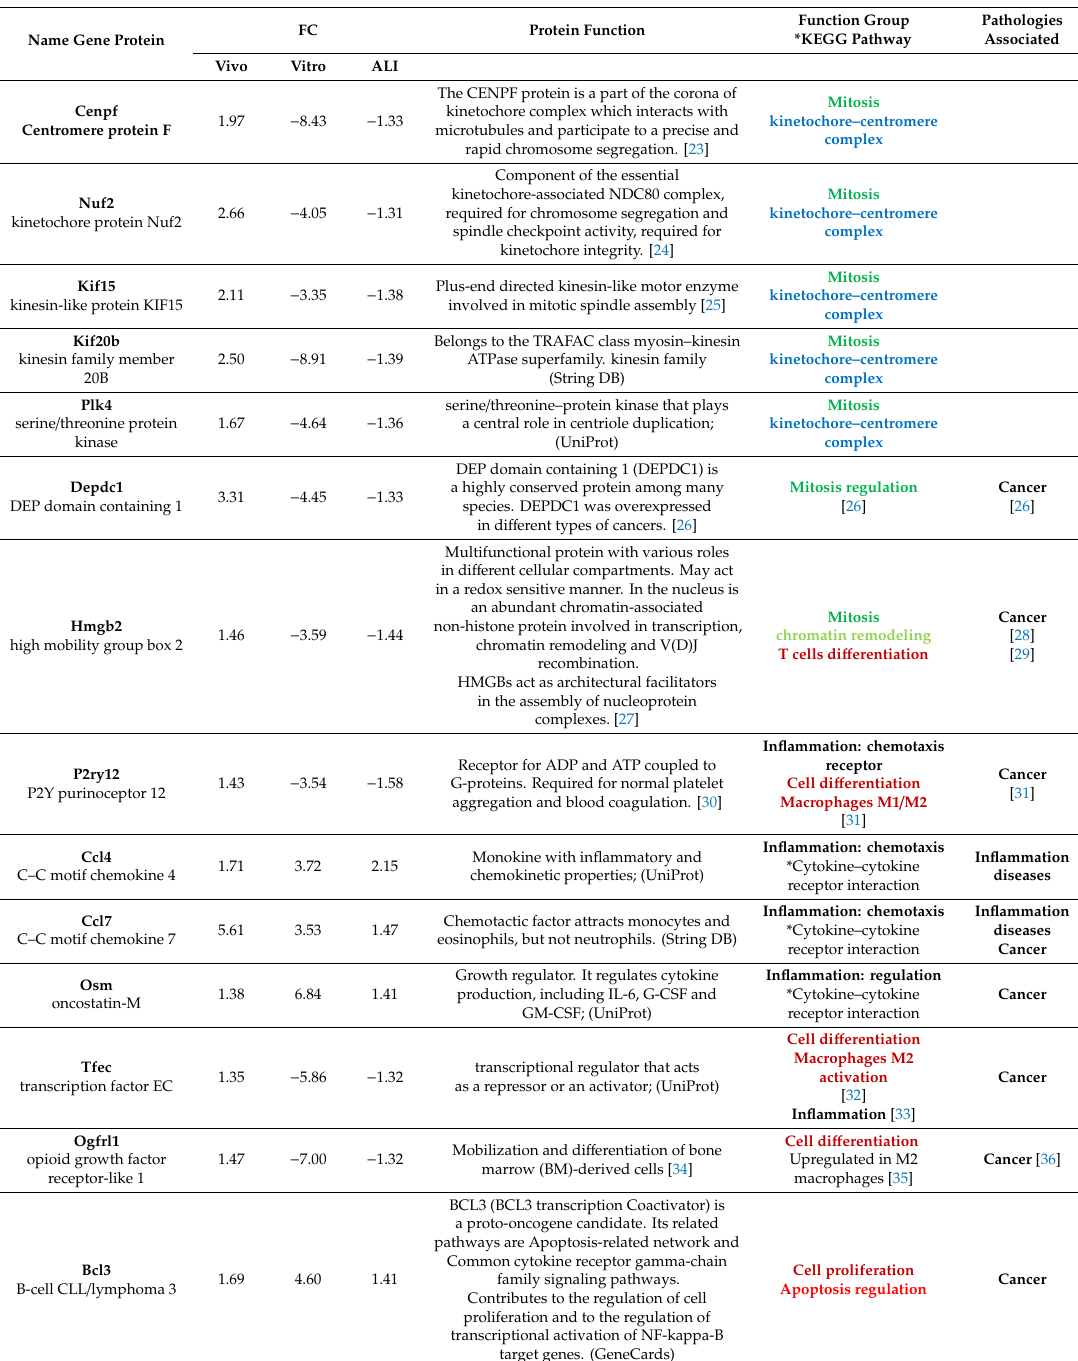
Table 4. Common genes between the three exposures (di ff erent group functions are highlighted in di ff erent colors, detailed information where found in GeneCards, UniProt, String, protein Atlas and PubMed databases). Colors in the function group column are used to identify common elements